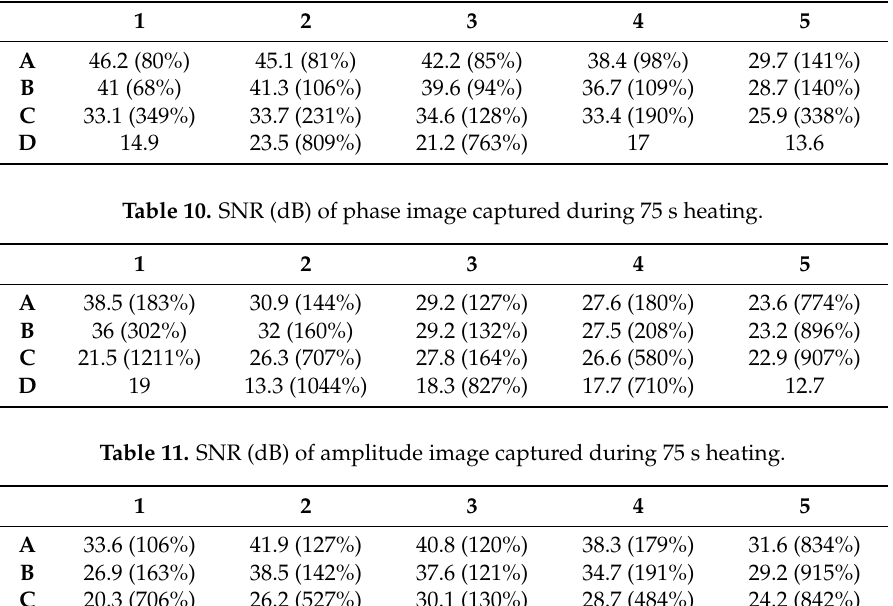
Table 9. SNR (dB) of amplitude image captured during cooling after 75 s heating.